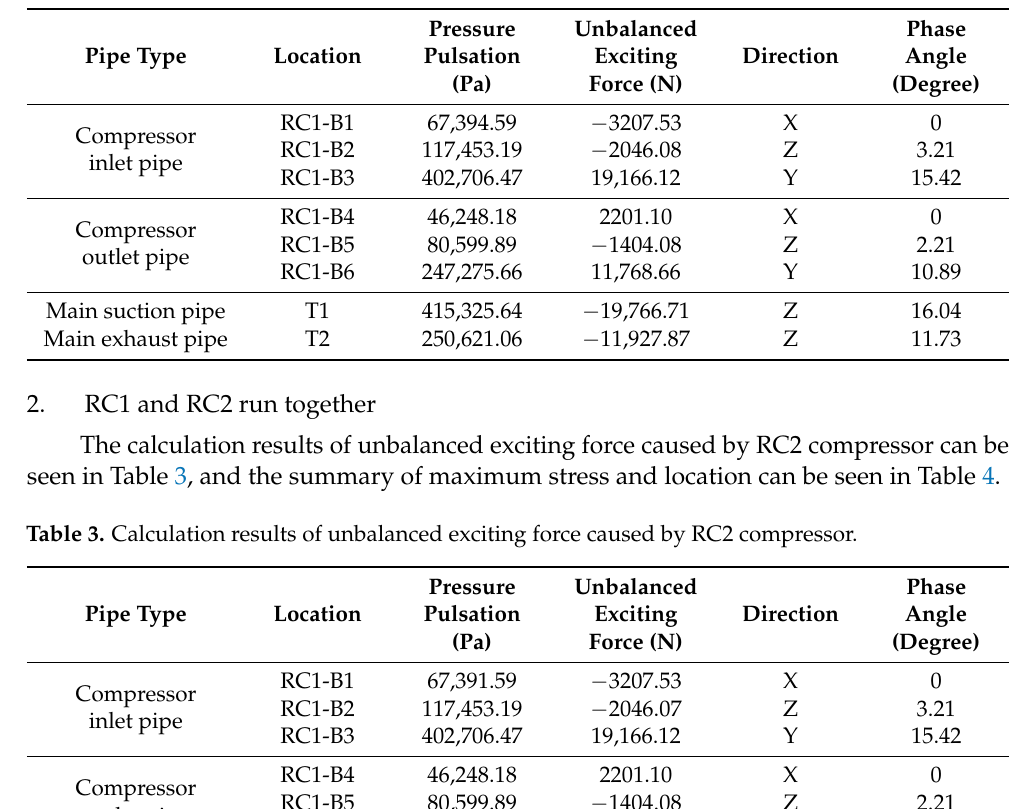
Table 2. Calculation results of unbalanced exciting force caused by RC1 compressor.